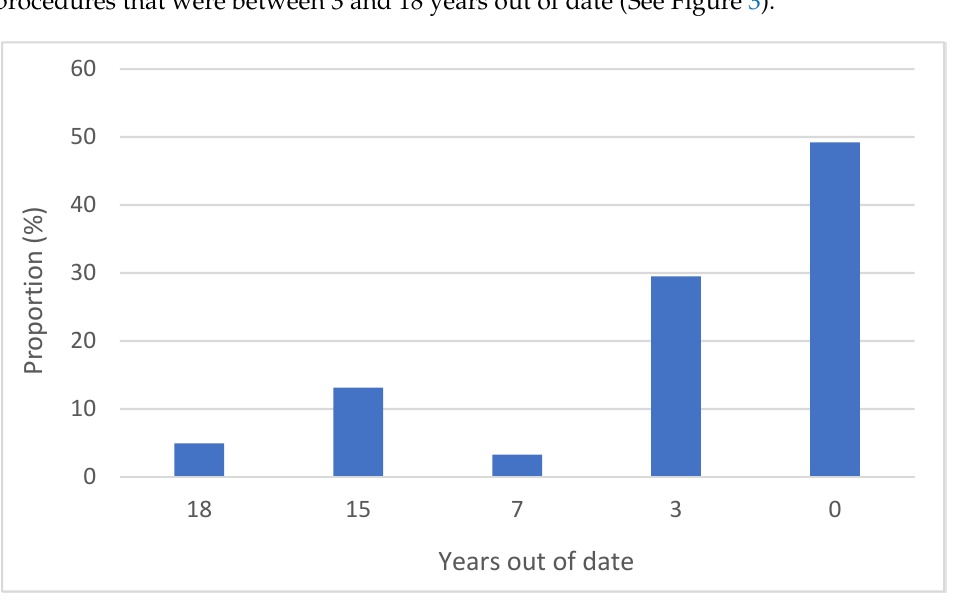
Figure 3. The number of years out of date the referenced guidelines were for a given publication in relation to the most recent guidelines available at the time of publication.